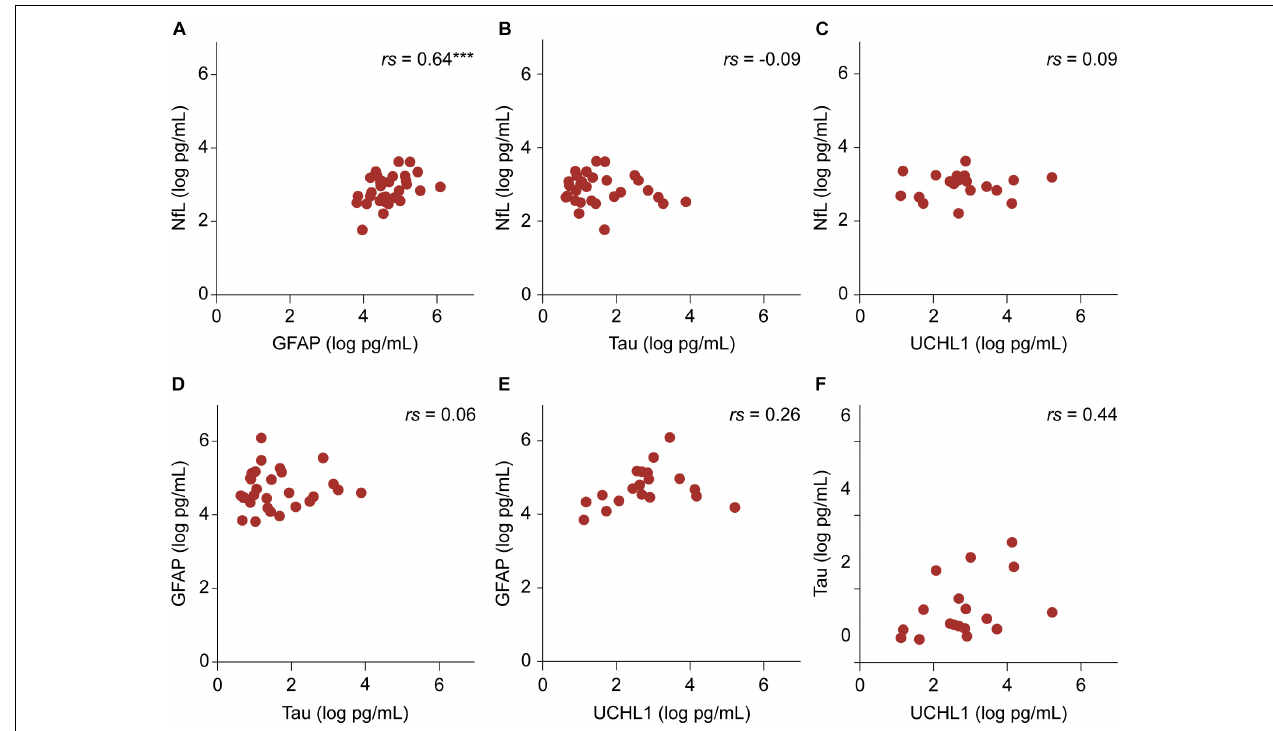
FIGURE 3 | The relationship between transformed biomarker concentrations in the patient group. (A–F) Partial correlation controlling for age are shown. The relationship between NfL and GFAP values was significant. ∗∗∗ p <